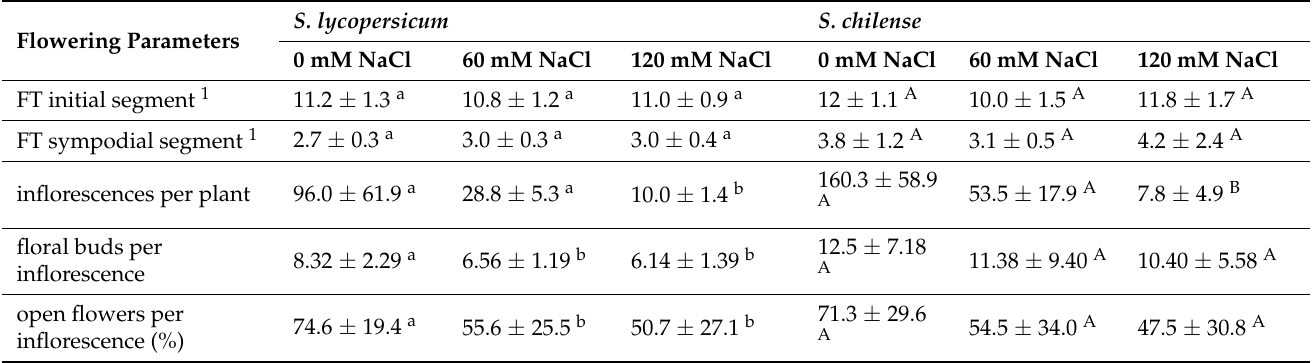
Table 1. Effects of salt stress on flowering parameters of Solanum lycopersicum and Solanum chilense grown at 0, 60, and 120 mM NaCl.